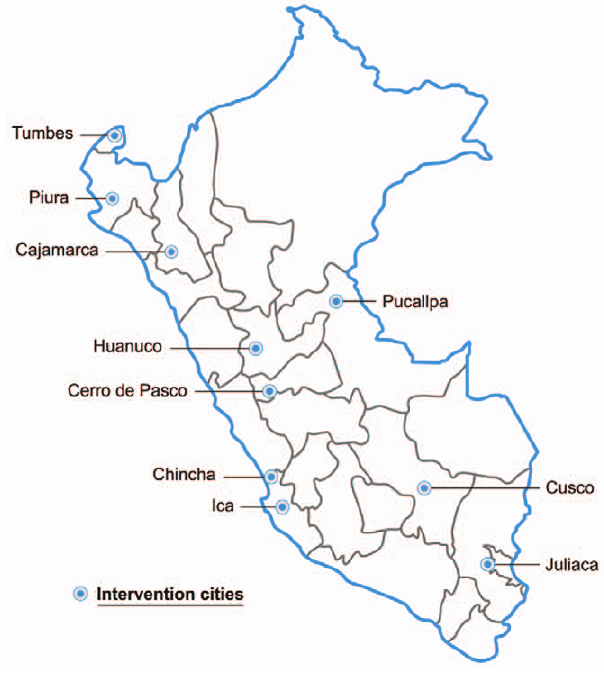
Figure 1. Map of Peru with the location of the 10 intervention cities (each city has more than 50,000 inhabitants).